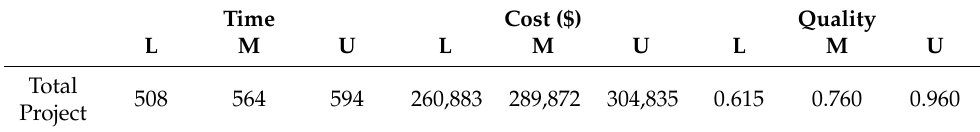
Table 5. Results of the project (project by 13 activities).